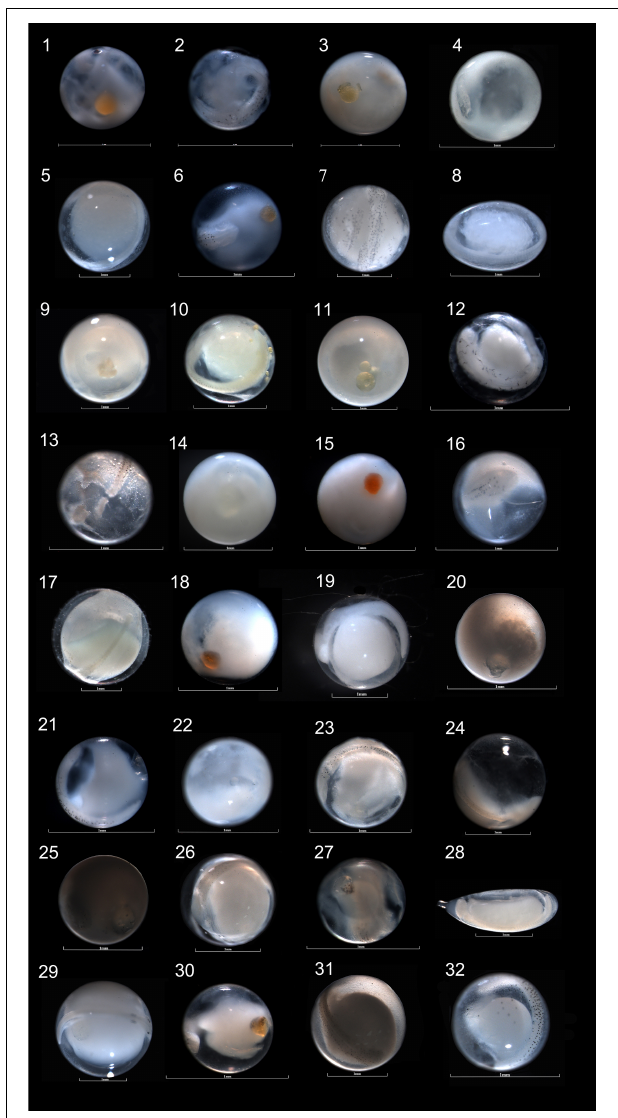
FIGURE 2 | Photographs of the egg specimens that were identified to species level by COI and cytb sequences in the eastern Beibu Gulf. (1) Acropoma japonicum , GDYH16088, 0.923 mm; (2) Atropus Atropos , GDYH16147, 0.719 mm; (3) Branchiostegus albus , GDYH15795, 1.106 mm; (4) Carangoides malabaricus , GDYH13119, 0.790 mm; (5) Chirocentrus dorab , GDYH13103, 1.784 mm; (6) Chrysochir aureus , GDYH16116, 0.766 mm; (7) Coryphaena hippurus , GDYH13118, 1.641 mm; (8) Encrasicholi heteroloba , GDYH12984, 1.178 × 0.792 mm; (9) Fistularia petimba , GDYH14150, 1.912 mm; (10) Hilsa kelee , GDYH13042, 1.234 mm; (11) Ilisha melastoma , GDYH13028, 1.401 mm; (12) Leiognathus ruconius , GDYH15838, 0.707 mm; (13) Megalaspis cordyla , GDH12789, 1.085 mm; (14) Mene maculate , GDYH13073, 1.085 mm; (15) Moolgarda perusii , GDYH16099, 0.833 mm; (16) Nemipterus marginatus , GDYH12936, 0.731 mm; (17) Oxyporhamphus micropterus , GDYH13048, 2.407 mm; (18) Parapercis lutevittata , GDYH15760, 0.976 mm; (19) Parexocoetus mento , GDYH13132, 1.719 mm; (20) Penhia anea , GDYH12757, 0.833 mm; (21) Penhia microcephalus , GDYH16123, 0.867 mm; (22) Penhia pawak , GDYH12932, 0.859 mm; (23) Pomadasys maculatus , GDYH12791, 0.897 mm; (24) Saurida elongate , GDYH15780, 1.430 mm; (25) Scomberomorus commerson , GDYH12756, (Continued)